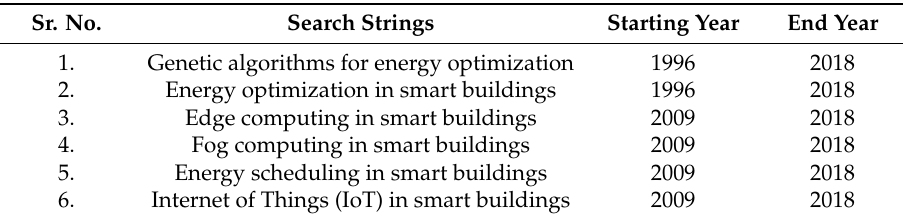
Table 1. Search strings for searching of the literature.